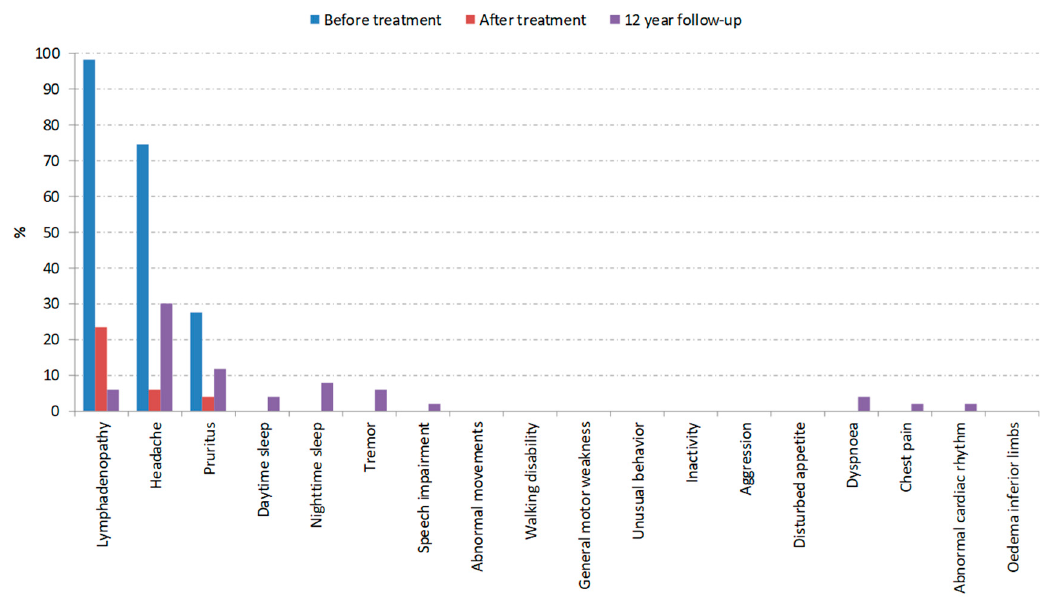
Figure 2. First stage HAT patients: Prevalence of signs and symptoms at different time points. Absence of a bar indicates 0% prevalence at a certain time point, except for dyspnea, chest pain, abnormal cardiac rhythm, and oedema, which were determined only at 12 year follow-up.